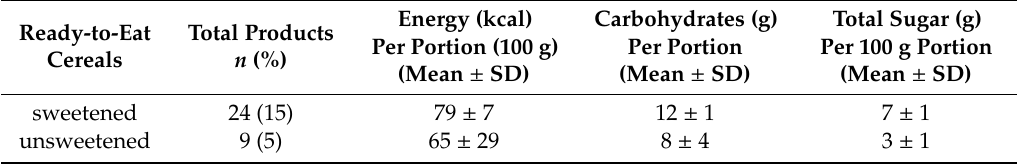
Table 4. Mean energy, as well as carbohydrate and sugar contents of sweetened and unsweetened ready-to-eat cereals, as reported on food